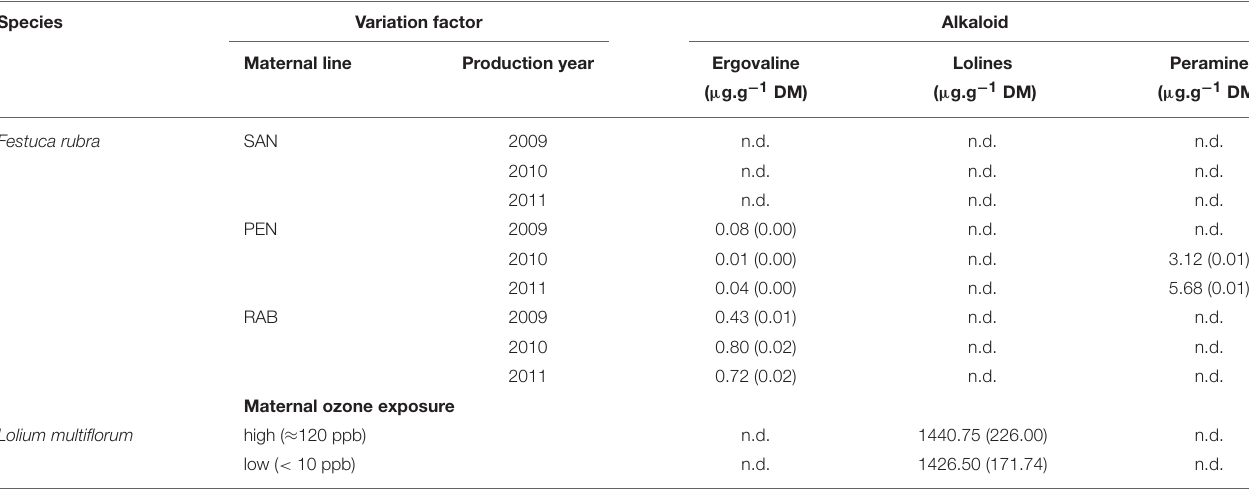
TABLE 1 | Concentration of fungal alkaloids in endophyte-symbiotic seeds of Festuca rubra and Lolium multiflorum as affected by “maternal line and production year”, and “maternal exposure to ozone,” respectively.